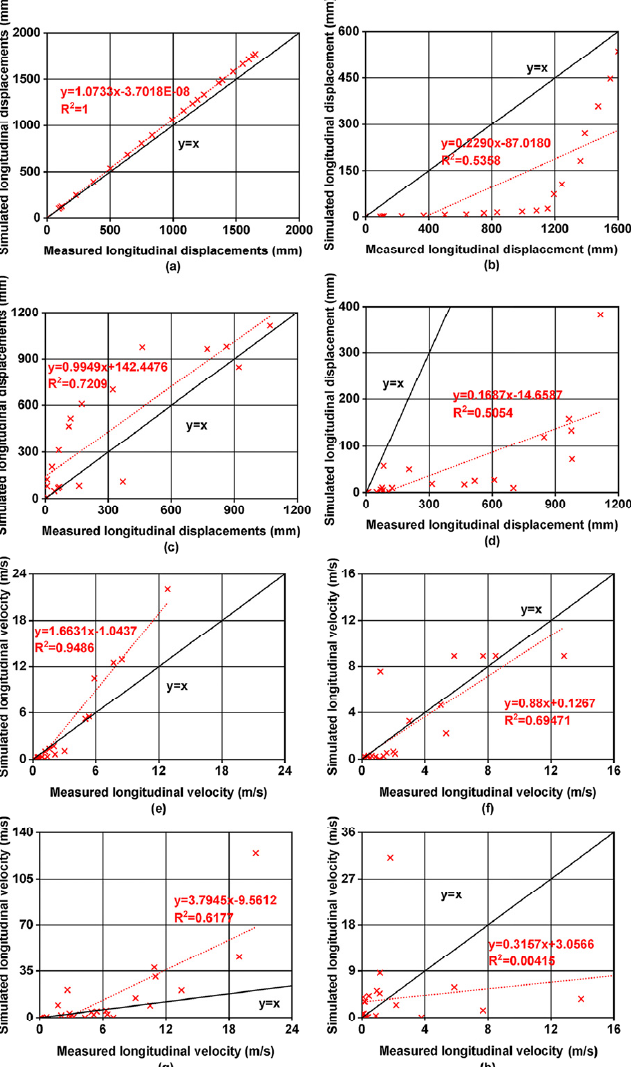
Figure 8. Correlation of longitudinal motion between the measured and simulated: ( a , b ) soil dis- placement in DEM-CFD and DEM model; ( c , d ) straw displacement in DEM-CFD and DEM model; ( e , f ) soil velocity in DEM-CFD and DEM model; ( g , h ) straw velocity in DEM-CFD and DEM model.